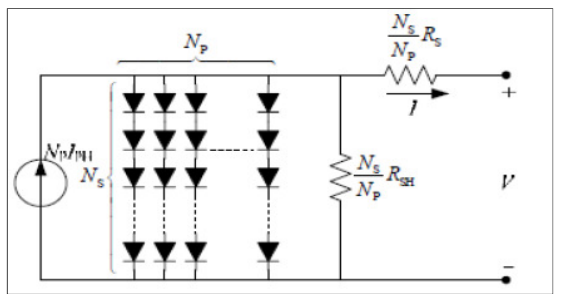
Fig. 3. General PV equivalent circuit model.